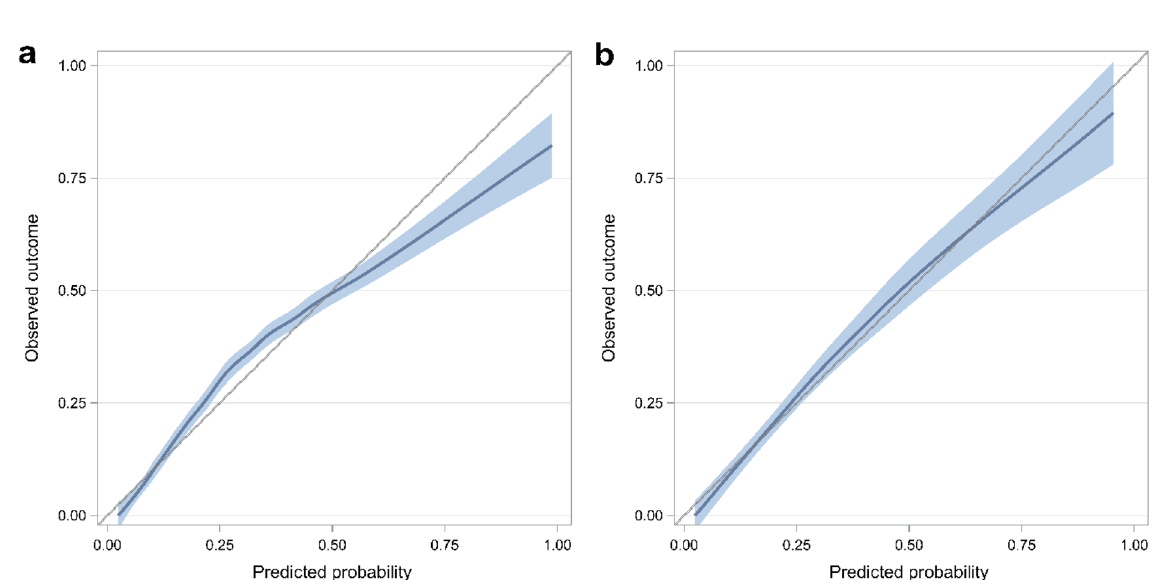
Figure 3. Calibration plot for predictive risk-score model for opioid overdose. ( a ) Calibration plot in the development cohort. ( b ) Calibration plot in the validation